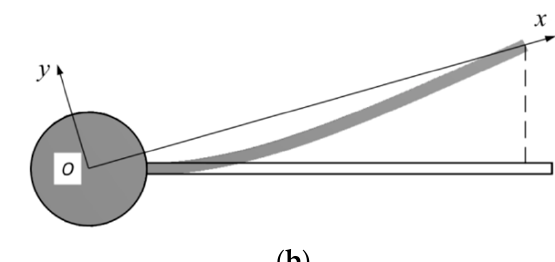
Figure 2. Sketch a single flexible-link, flexible-joint mechanism.